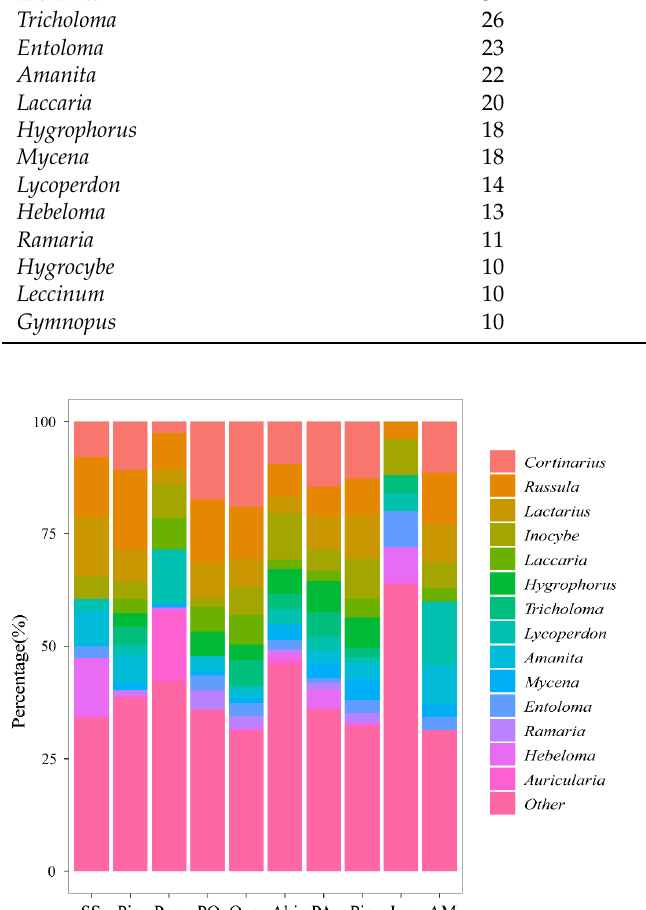
Figure 3. Bar chart of the major genera of macrofungal communities by vegetation type. The horizontal axis is the vegetation type, arranged from left to right according to the average elevation from low to high.